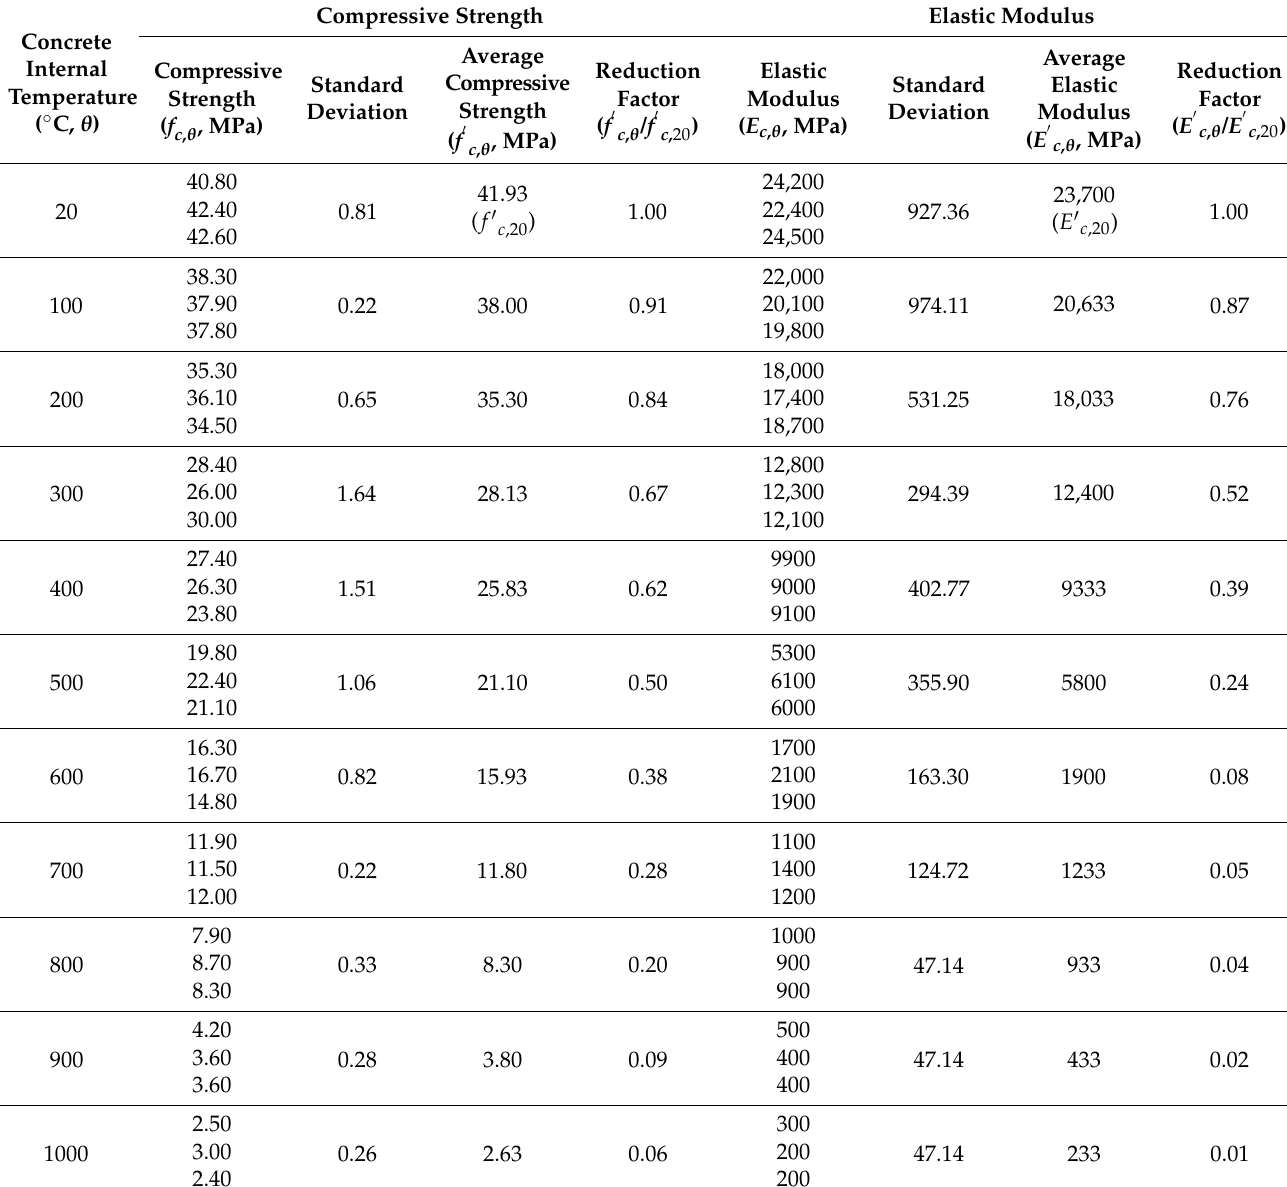
Table 1. Residual materials properties of siliceous concrete (35 MPa) after the